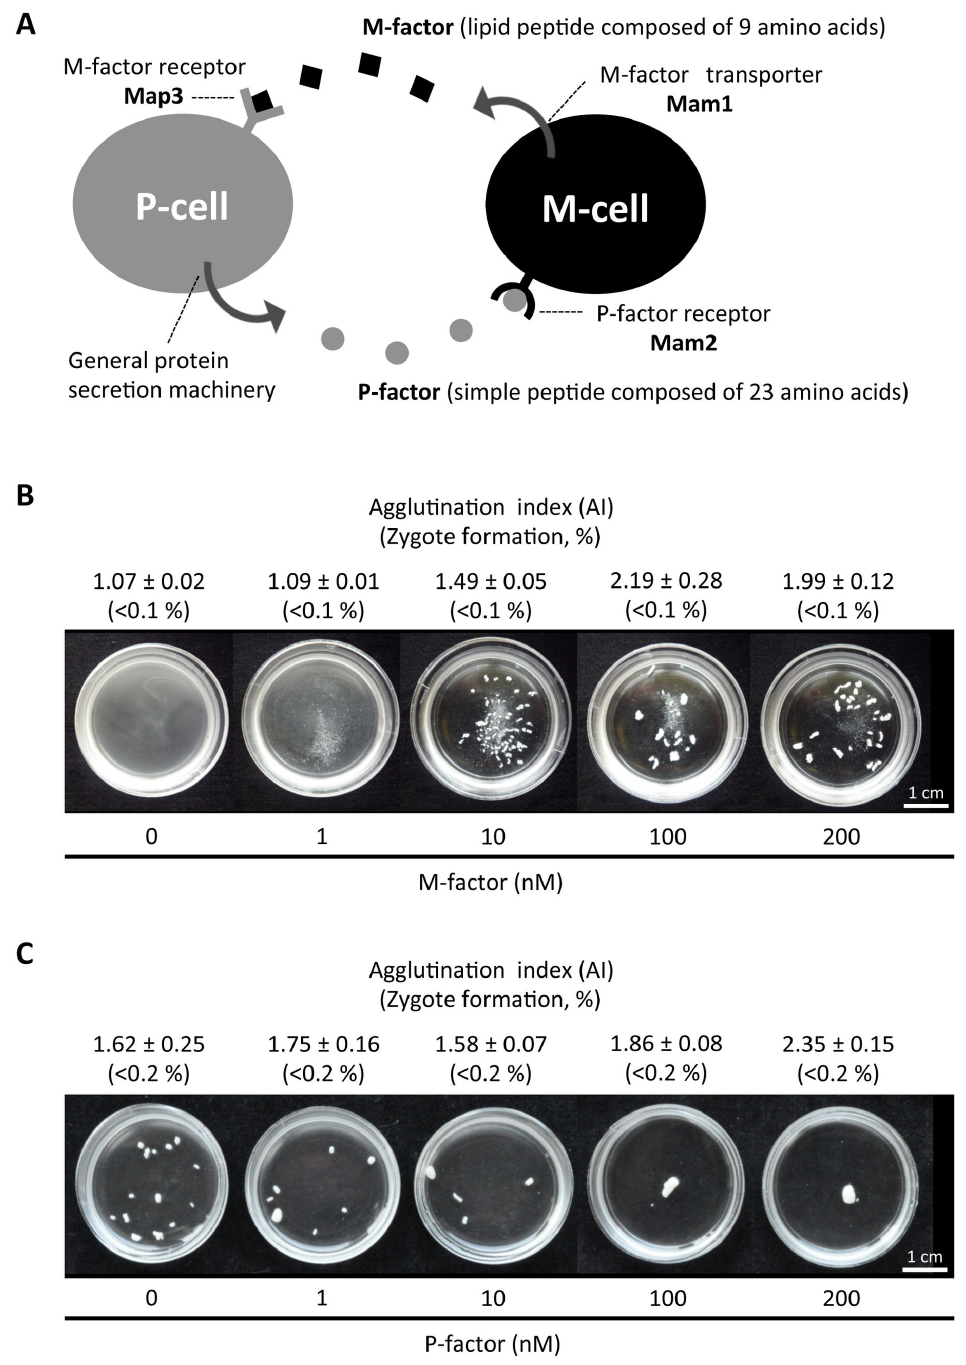
Figure 1. Induction of sexual agglutination by mating pheromone. (A) Illustration of mating pheromone signaling in S. pombe . The pheromone signal is transmitted through trimeric G-protein α-subunit and the mitogen-activated protein kinase cascade, comprising Byr2, Byr1 and Spk1. The signal transmission pathway is common to both M- and P-cells [22]. (B) The defect in sexual agglutination of the M-factor-less mutant was recovered by exogenously added synthetic M-factor. The homothallic strain FS55 was treated with synthetic M-factor for 4 hr in SSL−N. The agglutination index (AI) was determined for triplicate samples. Means with standard deviations are presented. A portion of each culture was incubated for 24 hr, and the frequency of zygotes was counted. At least 1,000 cells were examined for each sample. (C) Exogenous P-factor addition enhanced constitutive agglutination in a homothallic P-factor-less strain (FS251). At least 500 cells were observed for each sample. doi: 10.1371/journal.pone.0069491.g001 PLOS ONE |